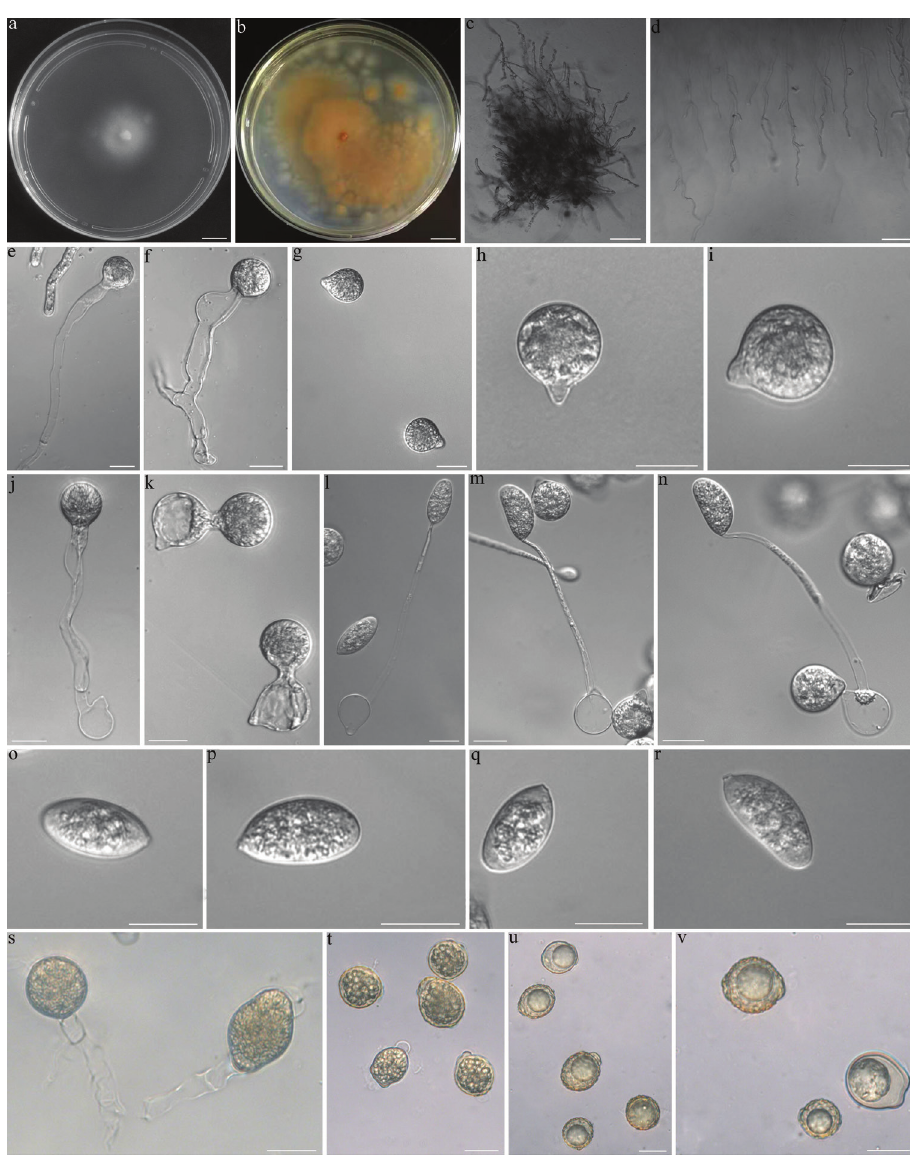
Figure 2. Capillidium macrocapilliconidium a colony on PDA after 3 d at 21 °C b colony on PDA after 10 d at 21 °C c Mycelia d Mycelia unbranched at the edge of the colony e, f primary conidiophores bearing primary conidia g, h, i primary conidia j, k primary conidia bearing a single secondary conidium i, m, n a primary conidium bearing a single capilliconidium o, p, q, r Capilliconidia s zygospores that were formed on adjacent segments of the same hypha t immature zygospores u, v mature zygospores. Scale bars: 10 mm ( a–b ); 100 μm ( c–d ); 20 μm ( e–v